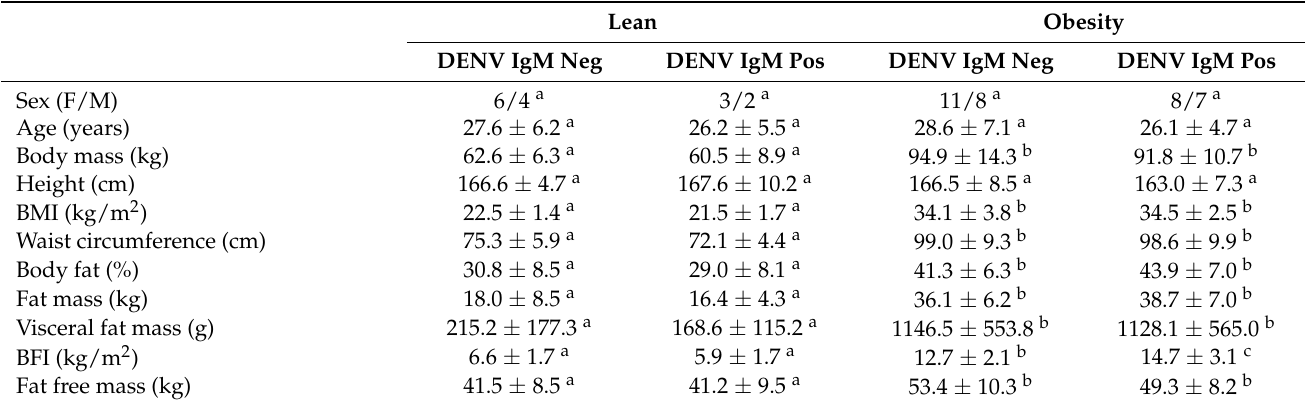
Table 1. Anthropometric data of study’s participants.